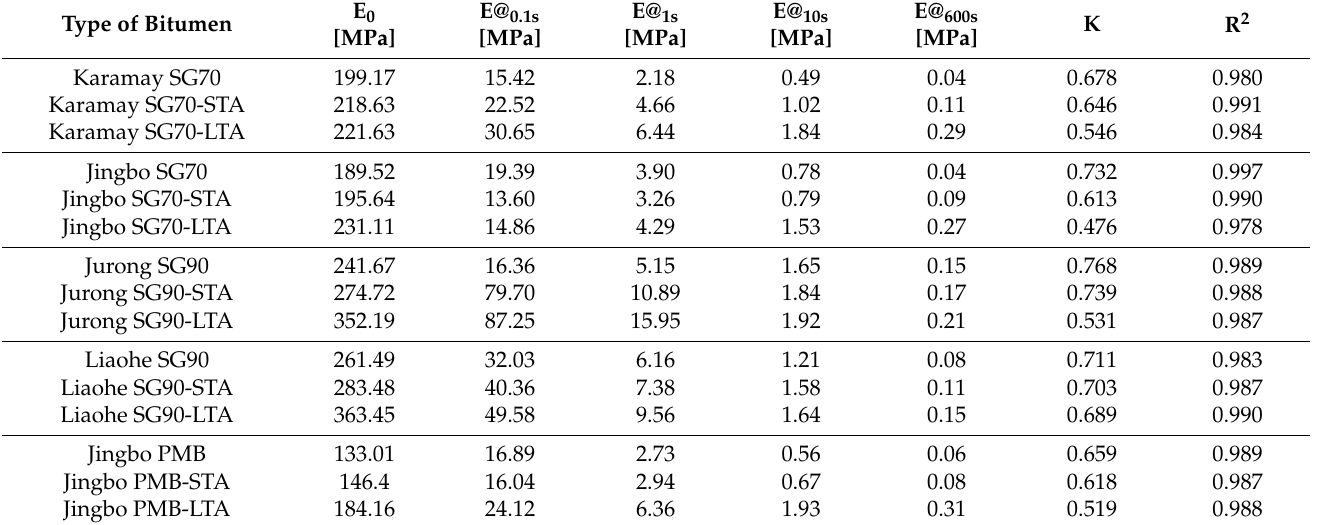
Table 7. Fitting results for the relaxation test at − 10 ◦ C.